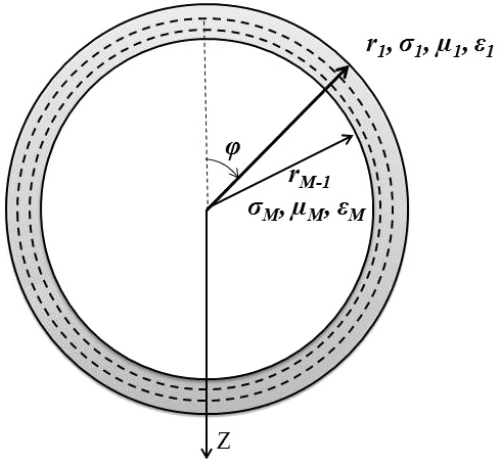
Figure 1. Schematics of the cylinder layers and coordinate system. The axis of the cylinder is coincided with x axis, propagation of the plane wave is along z axis, angle ϕ is clockwise as shown, the ex- ternal radius is r 1 , the internal is r M − 1 , intermediate layers from r 2 to r M − 2 (dashed circles). The corresponding electromagnetic char- acteristics are indexed as 1 for outside media, (2, ... , M − 1) for intermediate and M for the